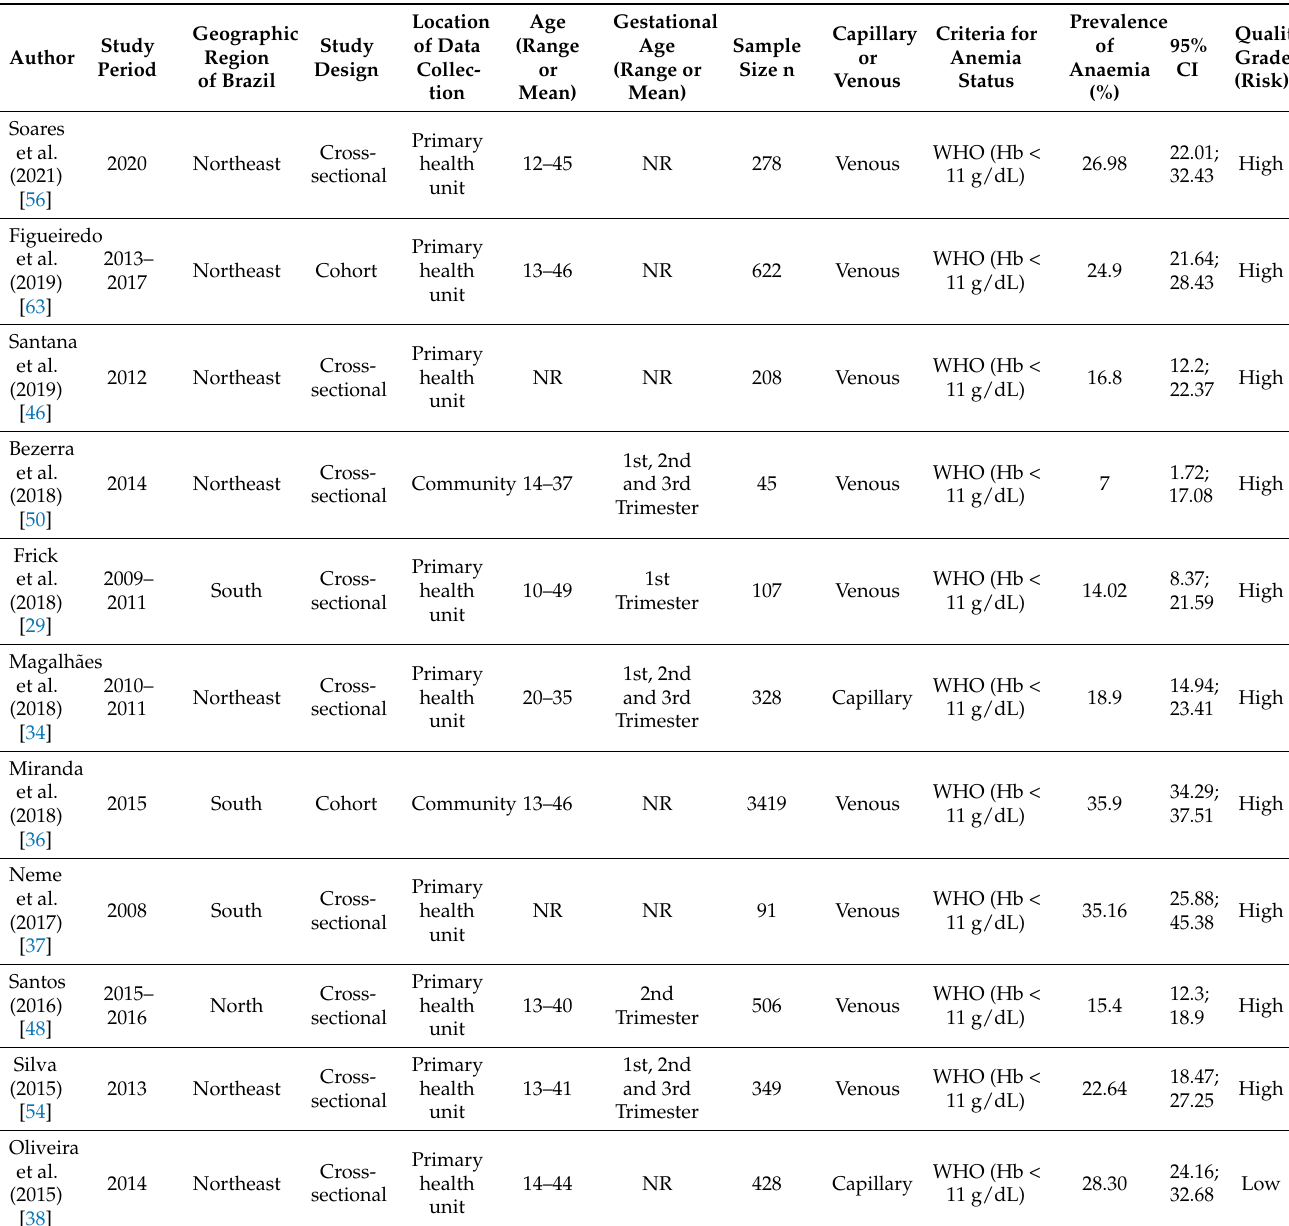
Table 1. Summary of included studies’